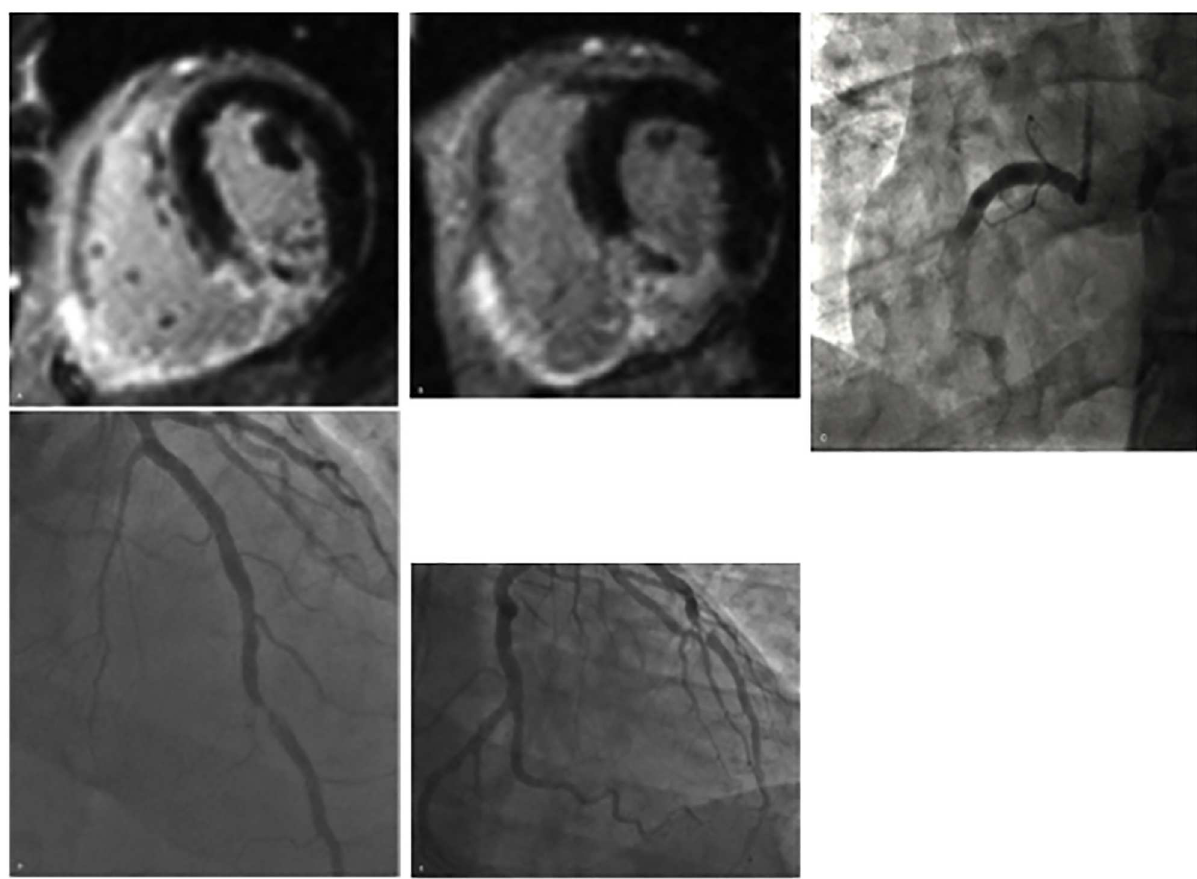
Fig 3. Right Ventricular Infarct on CMR and CA. CMR with evidenceof RV infarct (A and B). Angiography demonstrating RCA stenosis (C-E).